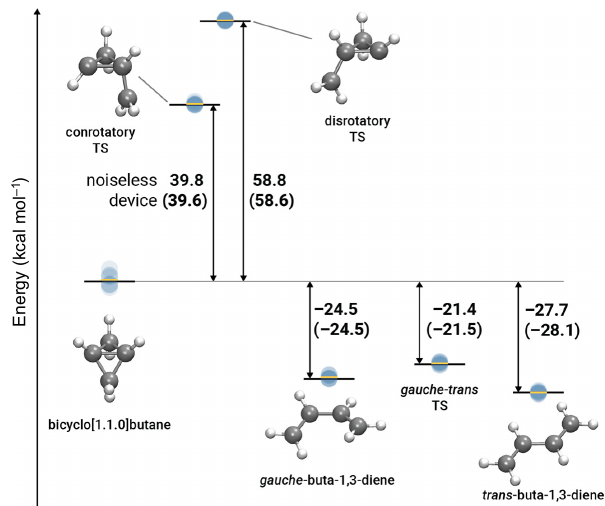
FIG. 5. Conrotatory and disrotatory pathways describing the isomerization of bicyclo[1.1.0]butane (bicyclobutane) to trans - buta-1,3-diene ( trans -butadiene). The enthalpies (in kcal mol − 1 ) are relative to the reactant for relevant stationary points com- puted with the 2-QLDSRG(2) method using one qubit on the device IBMQ_MANILA . The black horizontal bars represent the 2-QLDSRG(2) results obtained with noiseless simulations. The device results are shown in parentheses. The semiopaque blue circles aligned vertically show the distribution of the relative enthalpies from eight experiments (20 000 measurements per experiment), while the yellow horizontal bars denote the average relative enthalpies. We use a cc-pVTZ basis [85] (204 basis func- tions) and CASSCF(2,2) natural orbitals and the flow parameter for all six stationary points. value s = 1.0 E − 2 h